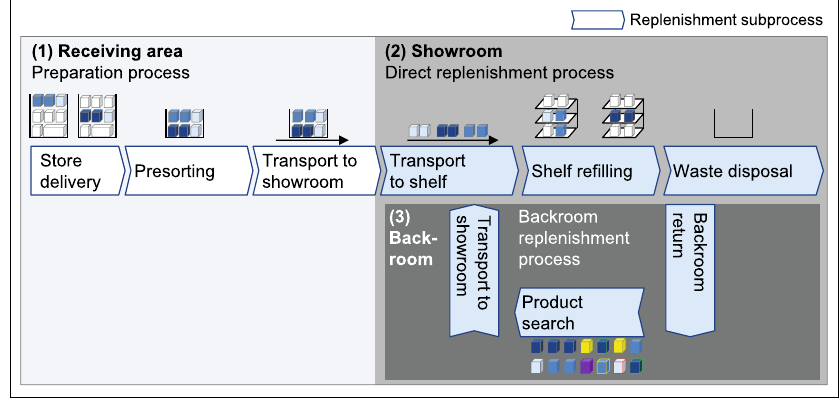
Fig. 2 Overview of related in-store logistics